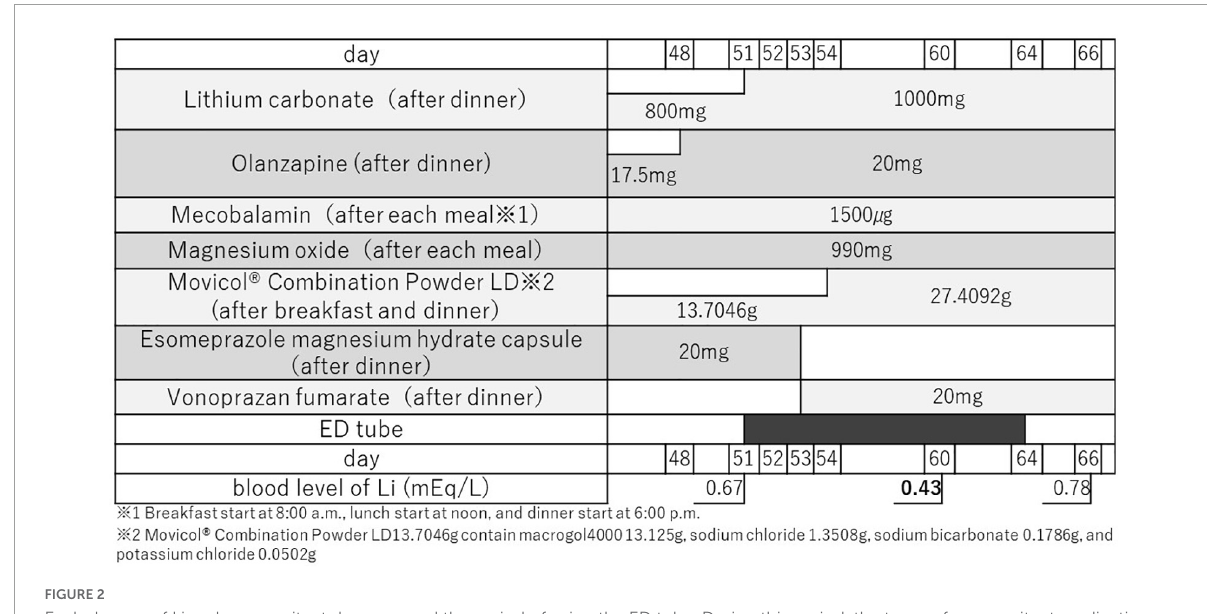
FIGURE2 Each dosage of Li and concomitant drugs around the period of using the ED tube. During this period, the types of concomitant medications were not changed. ED tube: elemental diet